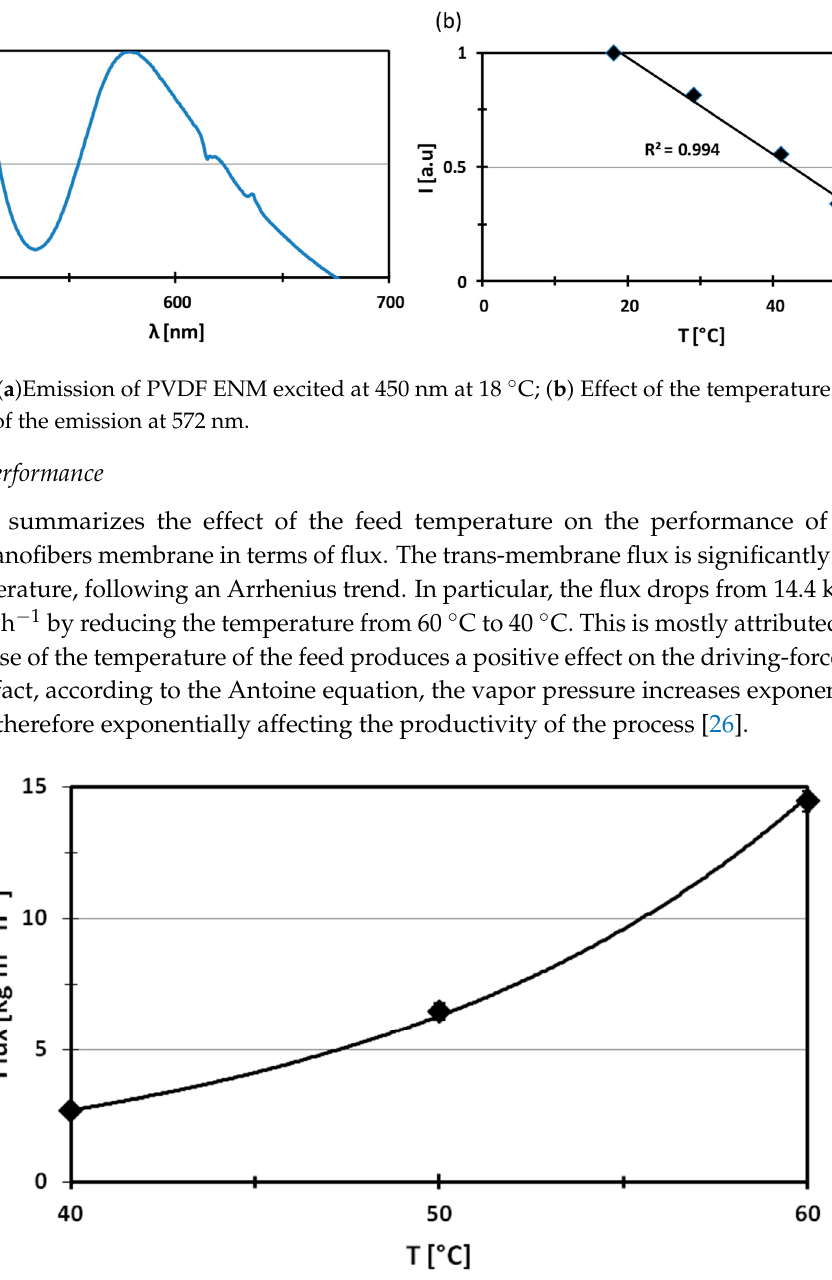
Figure 5. Effect of the feed temperature on the flux of PVDF ENM in DCMD process at a feed velocity of 0.008 m·s − 1 .